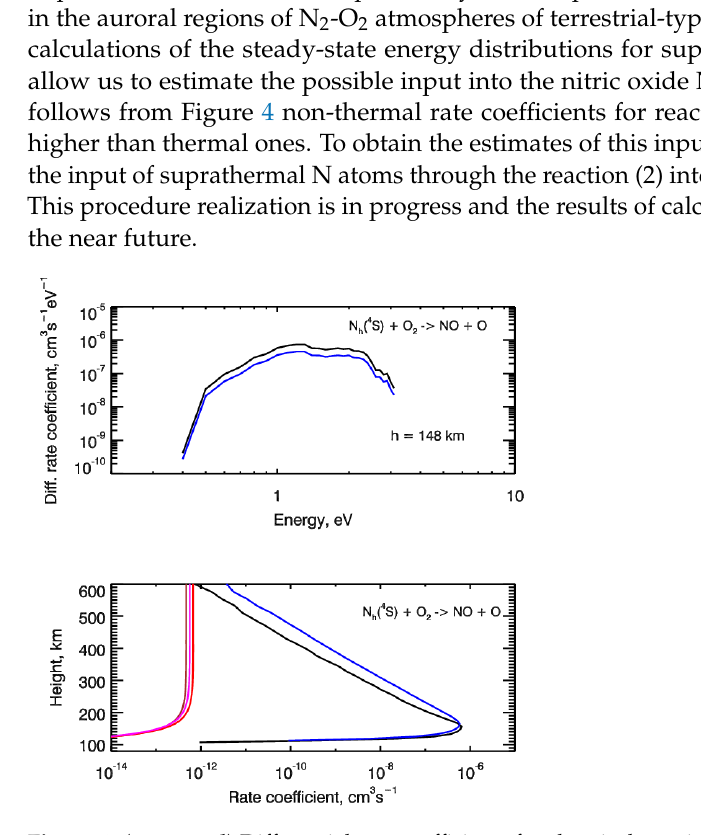
Figure 4. ( top panel ) Differential rate coefficients for chemical reaction between suprathermal N h ( 4 S ) atoms and molecular oxygen O 2 resulting in formation of nitric oxide NO calculated at height of 148 km. ( bottom panel ) Height profiles of the non-thermal rate coefficients calculated for the source function of the chemical reaction (2). Auroral electrons precipitate with monoenergetic spectrum at characteristic energy E 0 = 1 keV, and are described by monodirectional (black lines) and isotropic (blue lines) pitch-angle distributions at the upper boundary. The thermal rate coefficients for reaction (2) are also shown by the brown line [61], red line [62] and magenta line [63].